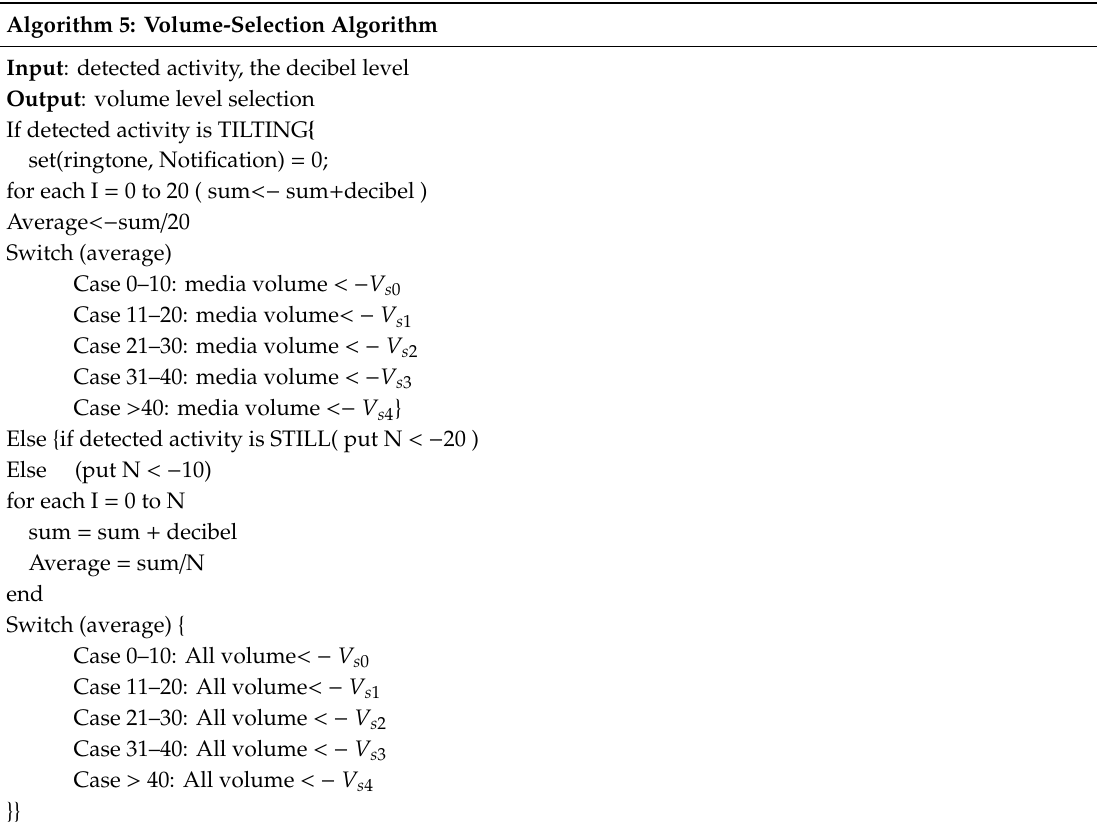
Algorithm 5: Volume-Selection